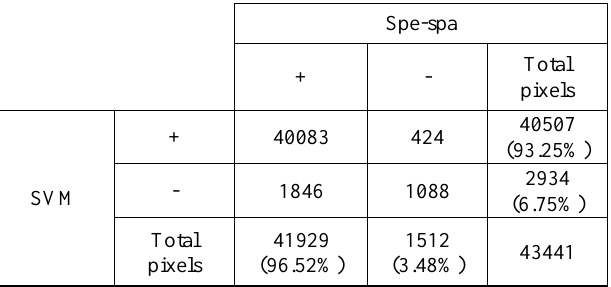
Table 2. Contingency table for comparison of classification